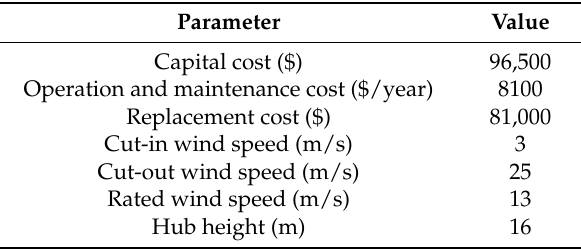
Table 2. Specifications of selected wind